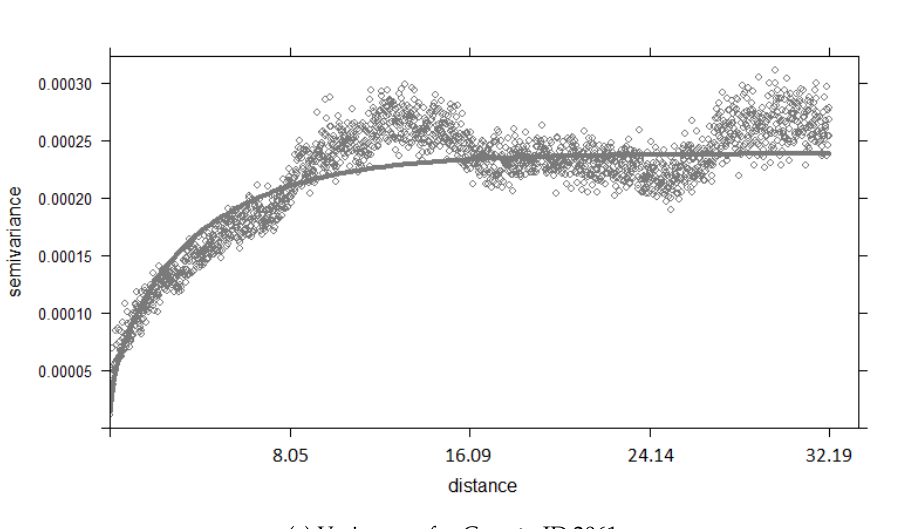
Figure 6. Empiracle Variograms (in kilometers).